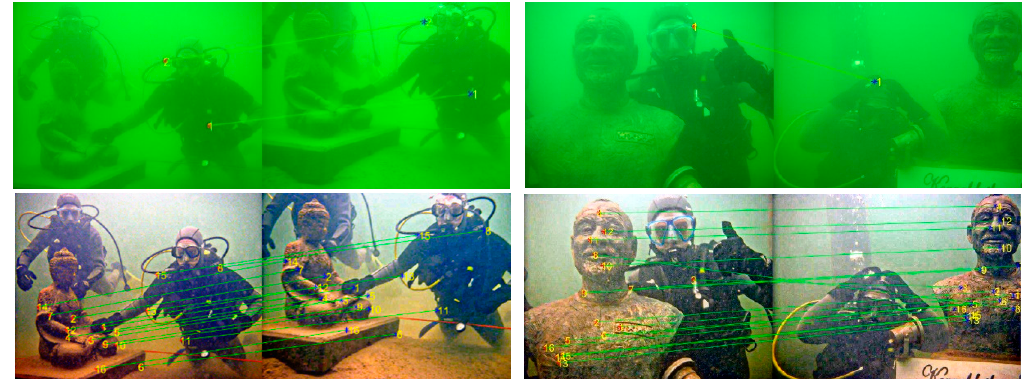
15 of 17 Figure 11. Robustness of the UIQM metric. Feature point matching is one of the basic tasks in computer vision algorithms,